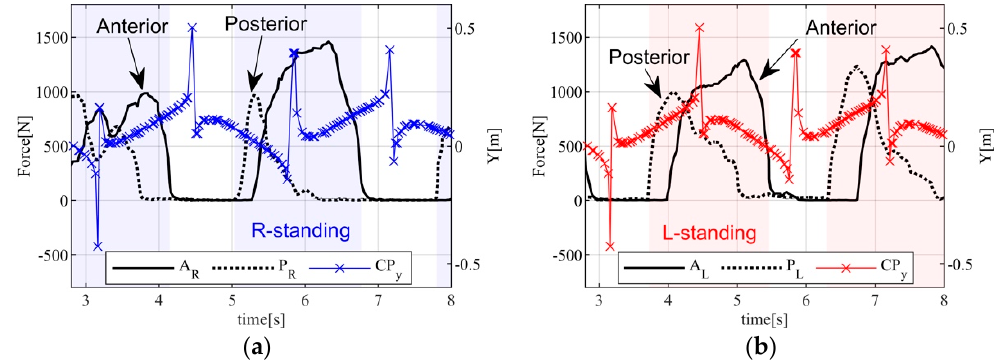
Figure 6. Results of foot pressure (unit: N) with CP (unit: m) detected from walking. ( a ) Results of right-foot pressure with CP (blue line: y CP , blue shadow: area stood by right limb); ( b ) results of left-foot pressure with CP (red line: y CP , red shadow: area stood by left limb).